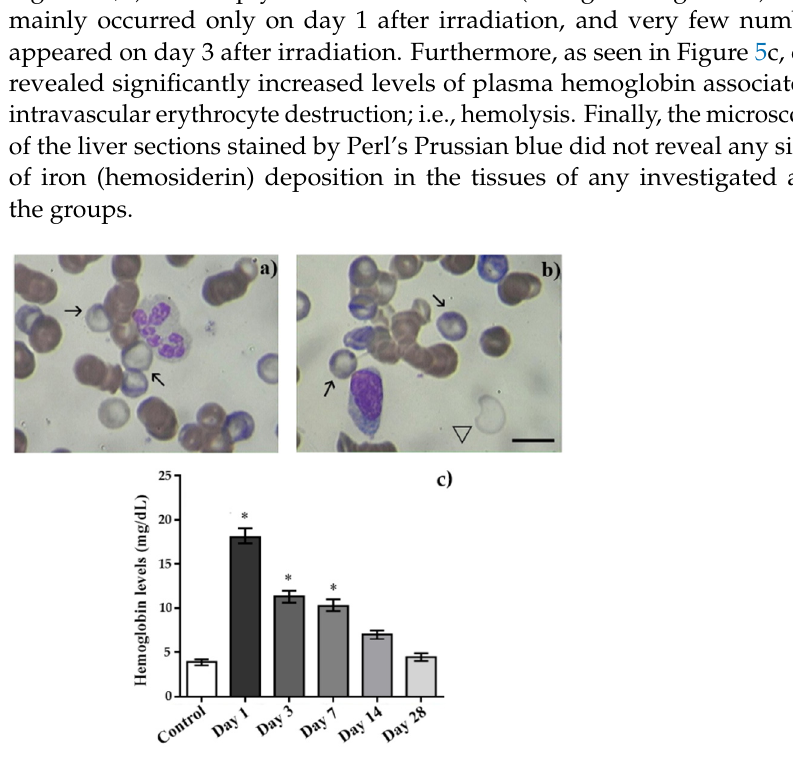
Figure 5. Evidence of hemolysis in peripheral blood samples of control and irradiated animals measured on the 1st, 3rd, 7th, 14th, and 28th day after irradiation with the laser-driven UPEB. ( a ) Ghost RBC (arrows) in rat blood smears on 1st day after irradiation; ( b ) ghost RBCs (arrows); membrane of RBC (triangle); ( c ) hemoglobin levels in plasma samples of control and irradiated animals. * p < 0.05 (compared to control). Scale bar is 10 μ m.